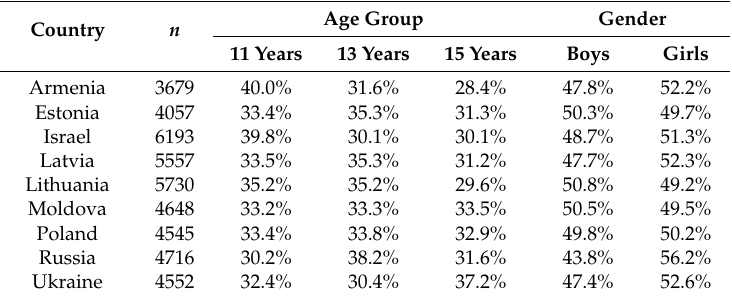
Table 1. Study sample by age and gender in analysed